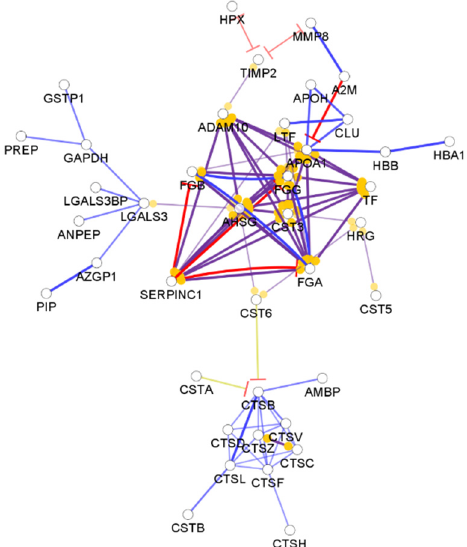
Figure 4. Partial network view of the interaction network of the chemical barrier proteins in sweat. Each circle represents a protein and the lines indicate interactions. The lines with an arrow represent activation, blocking lines represent inhibition, and simple lines represent protein–protein interaction. Line color indicates the type of interaction: green color refers to activation, red color to inhibition, blue color to binding, yellow color to co-expression, and purple color to catalysis. The proteins are labeled with their gene name. The high resolution and complete network image of this network is presented in Figure S4.